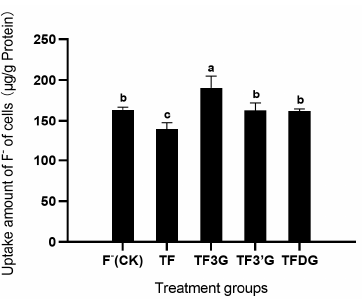
Figure 4. Uptake of F − in Caco-2 cells under different TFs treatments for 2 h. Different lowercase letters in the same group indicate significant differences at p < 0.05.